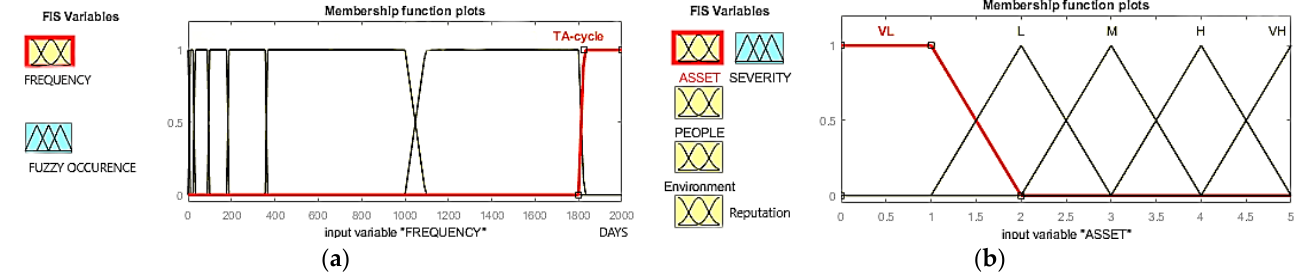
Figure 2. Fuzzy set: ( a ) Plot of frequency membership function; ( b ) input variable asset membership function plot.